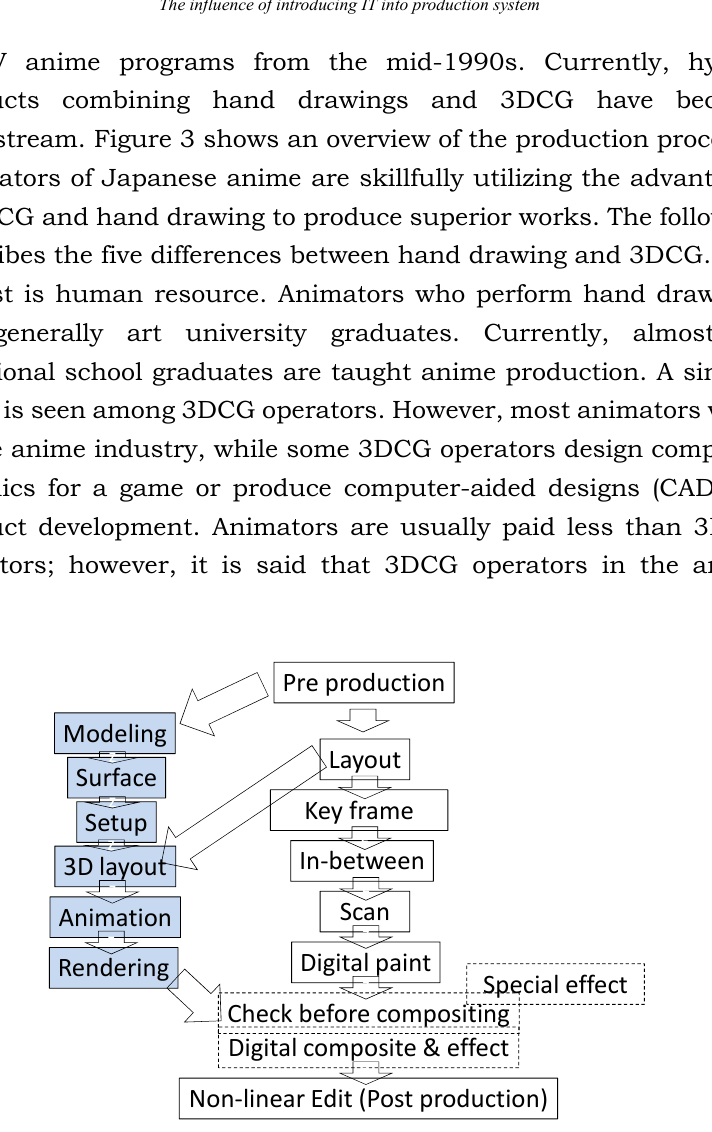
Figure 3. Main production process after introducing